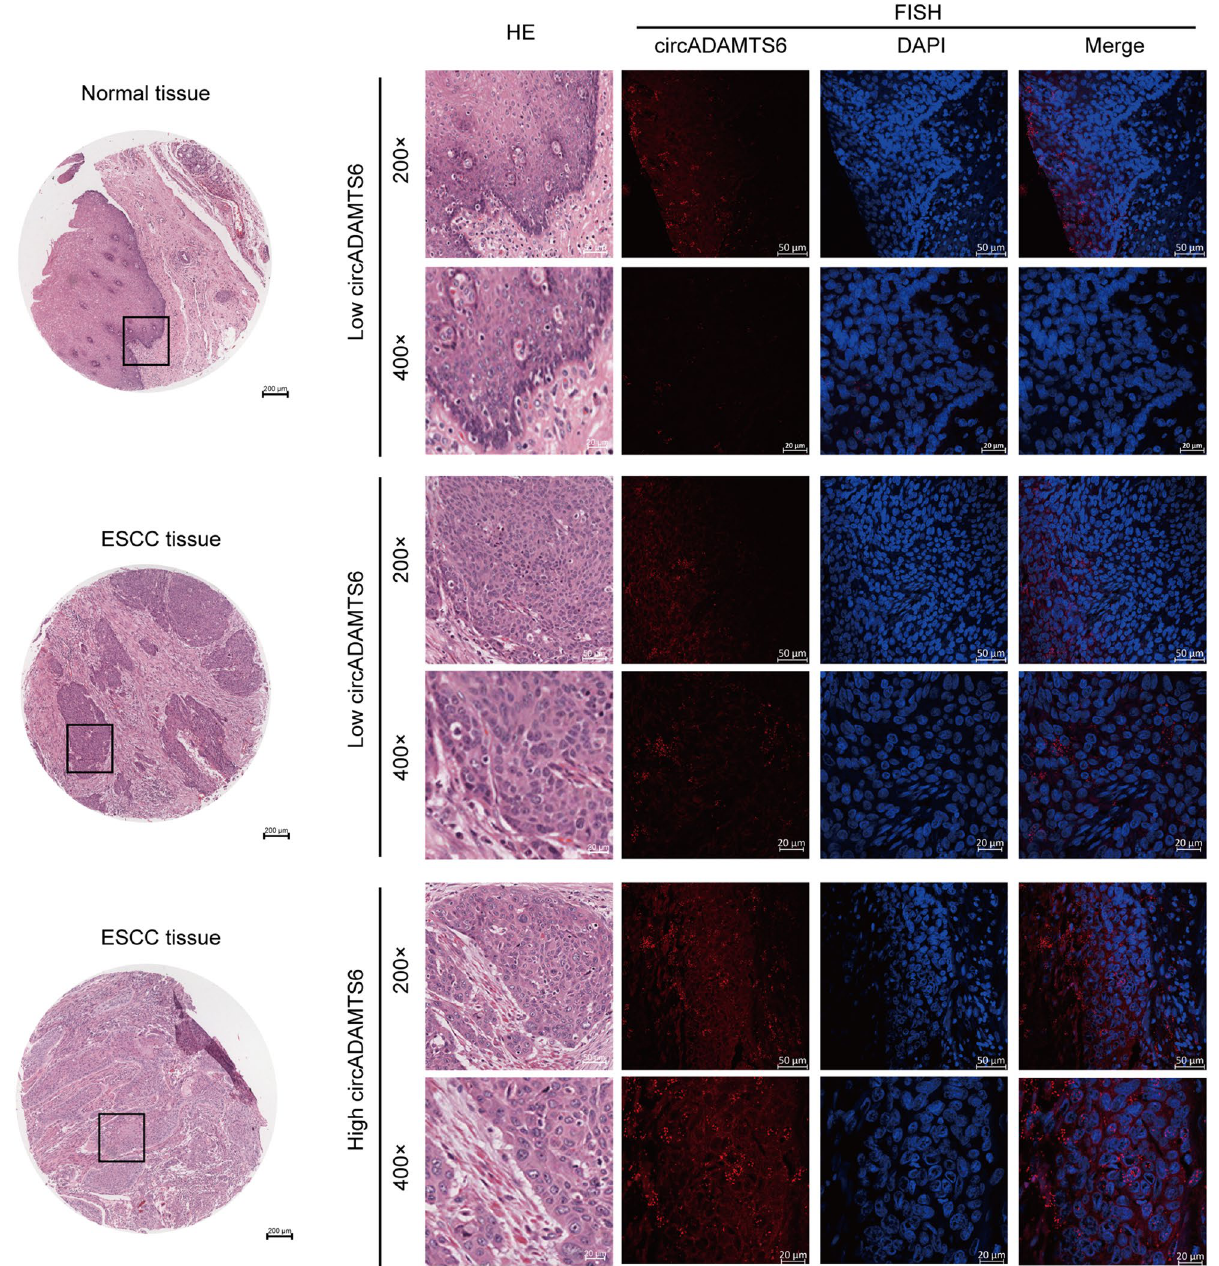
Figure 3. Different expression levels of circADAMTS6 in ESCC tissues and adjacent normal tissues. A comparison of two tissues, an increased expression of circADAMTS6 was discovered in ESCC tissues in our TMA-FISH